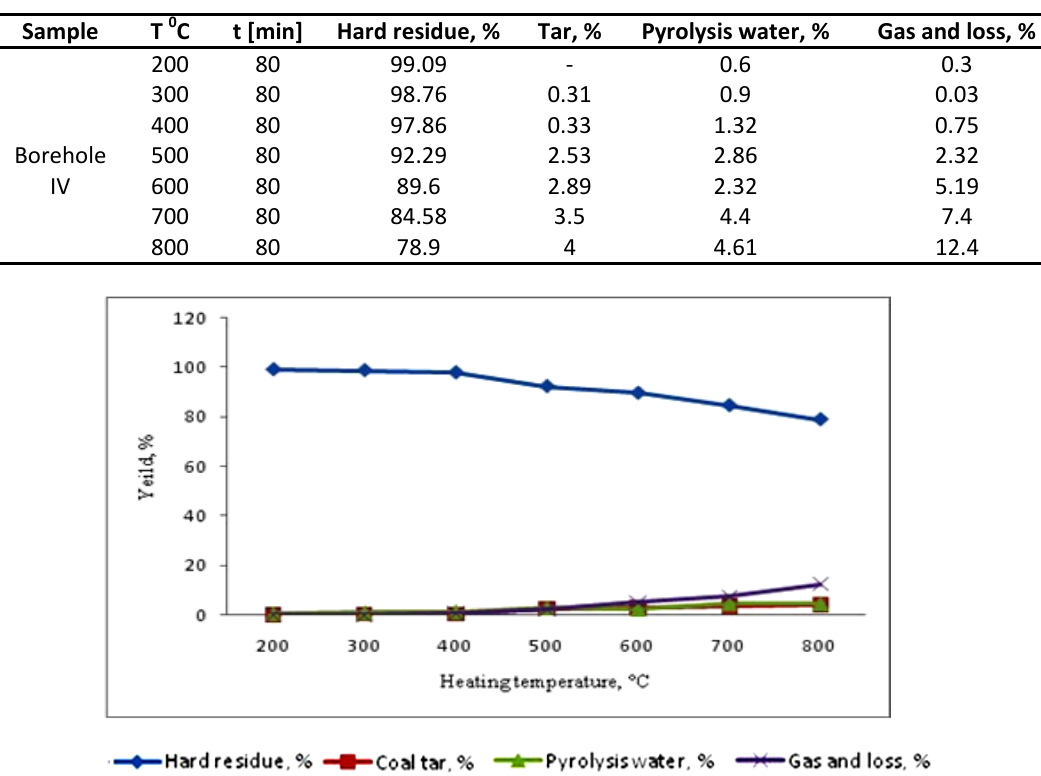
Fig. 7. The yields of pyrolysis products of borehole IV from Tavan tolgoi